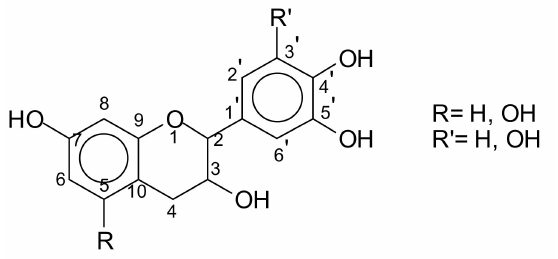
Figure 3. The structure of a flavonoid